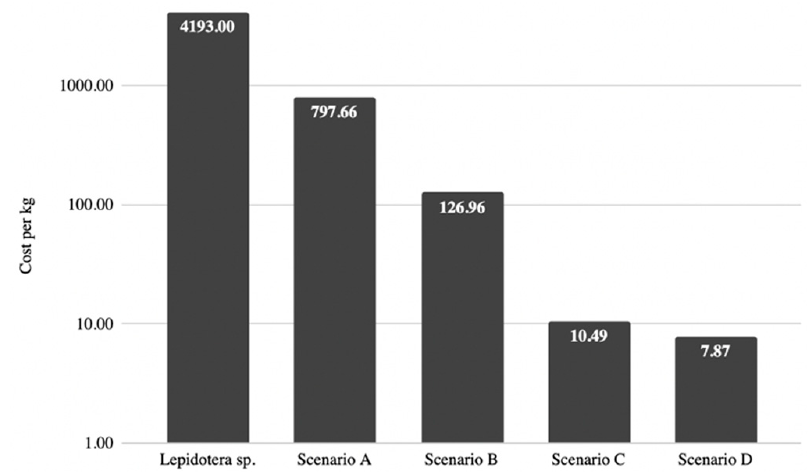
Figure 1. Summary of calculated costs of meat per kilogram according to model for each proposed cost reduction scenario.